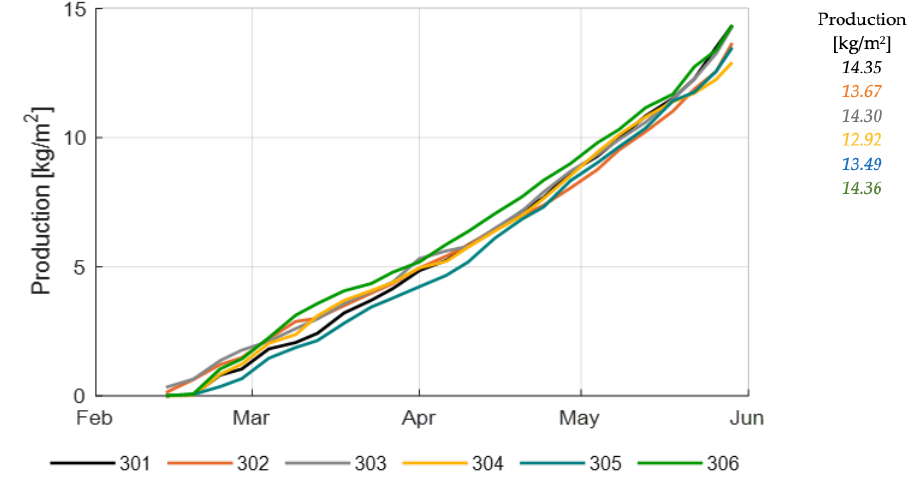
compartments (301 –